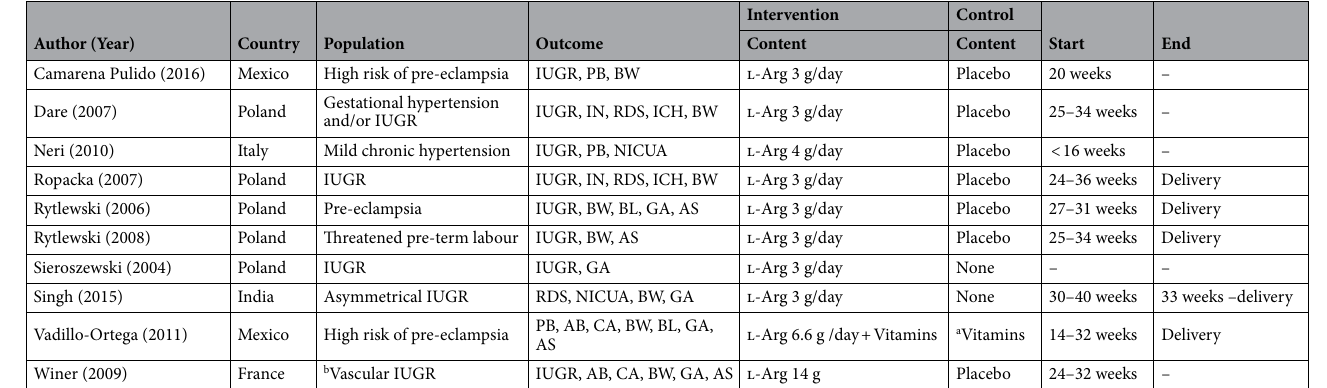
Table 1. Characteristics of the included. AB abortion; Arg arginine; AS Apgar score; BL birth length; BW birthweight; CA Caesarean section; GA gestational age; ICH intracranial haemorrhage; IN infection; IUGR , intrauterine growth retardation; NICUA neonatal intensive care unit admission; PB pre-term birth; RDS respiratory distress syndrome. a Vitamins alone were used as controls to accurately evaluate the effects of l-arginine, although another group used a placebo control rather than vitamins. b Foetal abdominal circumference ≤ the 3rd percentile for gestational age and abnormal uterine Doppler